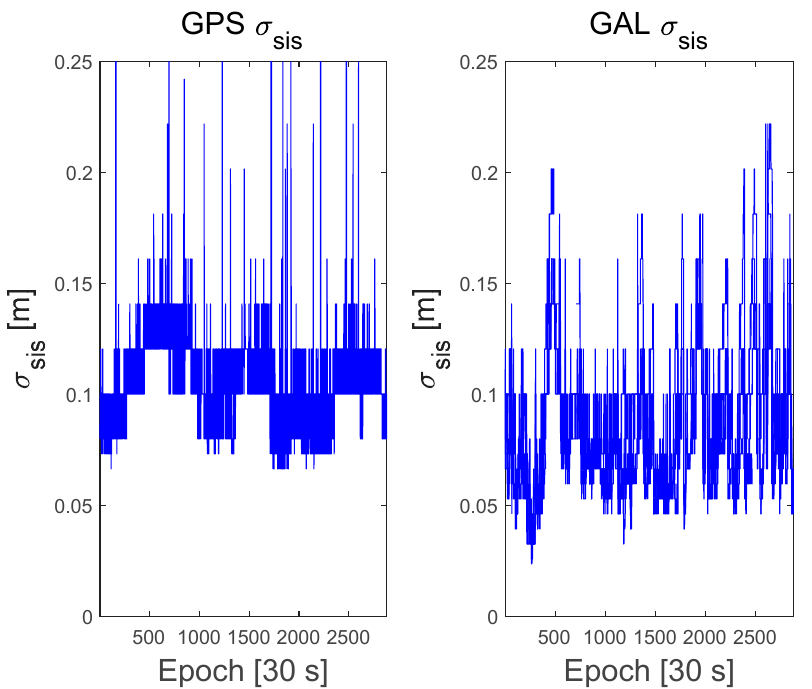
Figure 6. Time series of the Signal in Space correction quality, σ sis , for GPS and Galileo satellites.